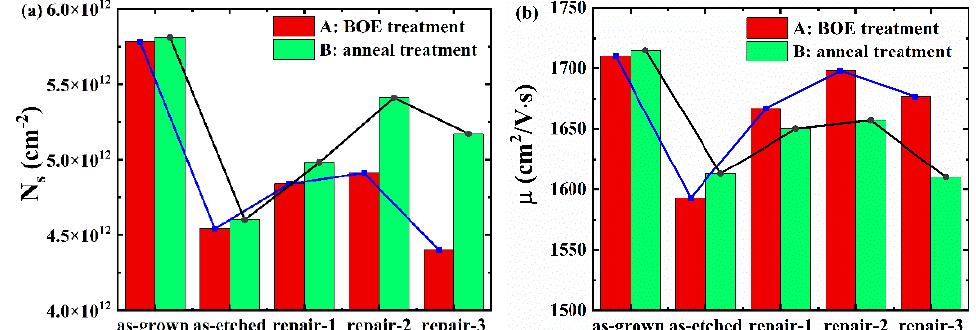
Figure 2. ( a ) The N s of sample A and sample B in different states, ( b ) the μ of sample A and sample B in different states.